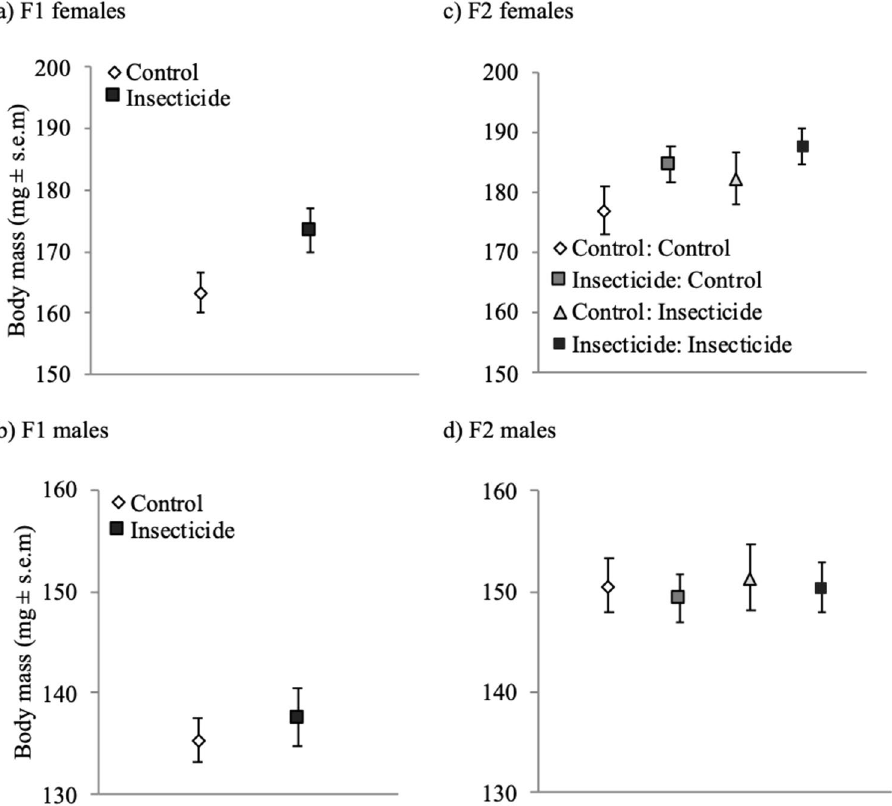
Figure 2. Body mass for ( a ) female and ( b ) male Colorado potato beetles in the first generation measured at the age of 10 days. Body mass for ( c ) female and ( d ) male beetles in the second generation measured at the age of 7 days. Control: Control- offspring control: maternal control (within-generational treatment: transgenerational treatment).